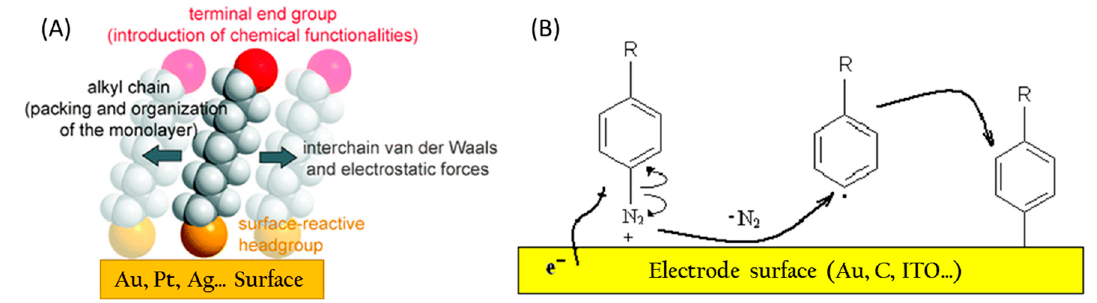
Figure 4. Representation of ( A ) self-assembled monolayer [83] and ( B ) scheme for electrografting of diazonium salts on electrode surfaces (Au, C or Indium Tin Oxide (ITO)) with alterable terminal chemical functionality.